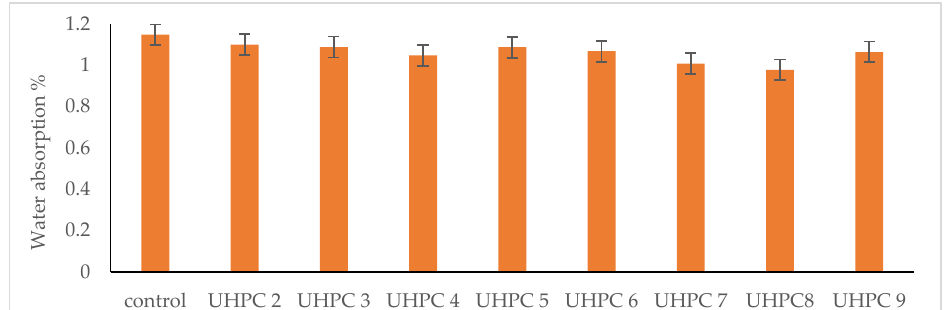
Figure 9. Water absorption values after 90 ages for glass powder replacement ratios.